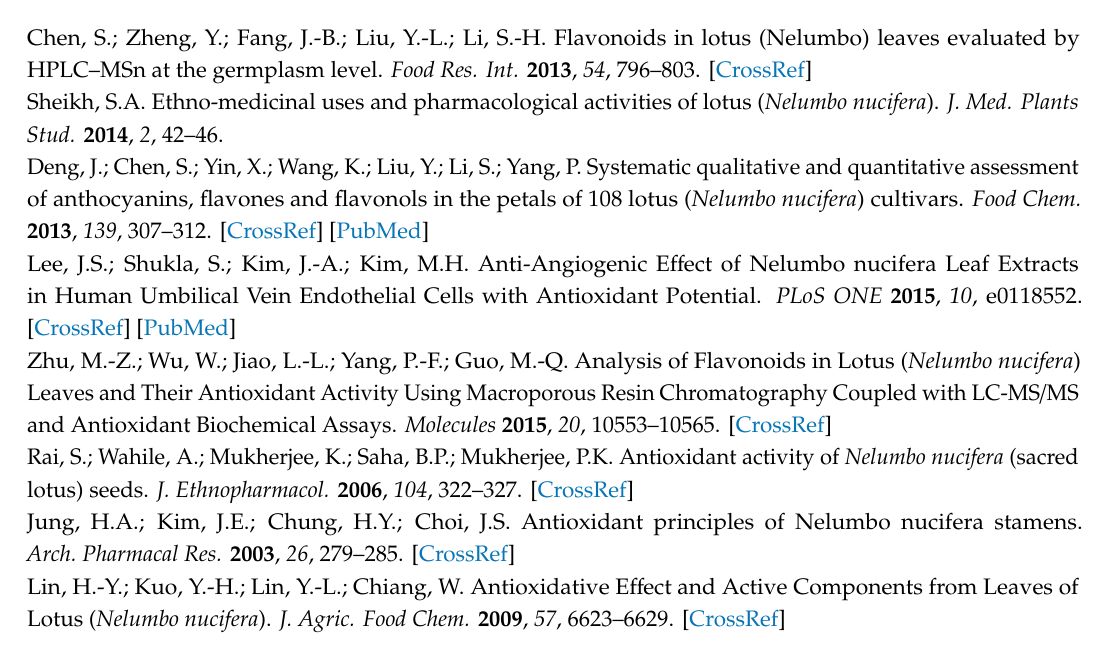
Table S1. Relative quantification (expressed in absorbance unit per g dry weight (DW)) of the di ff erent flavonoid glucosides in N. lotus and N. nucifera stamen